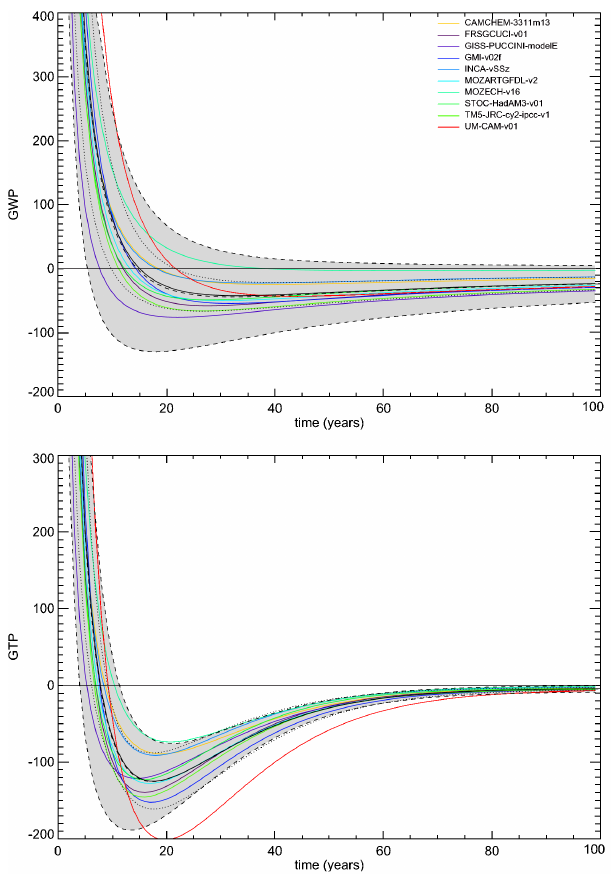
Figure 5. Time evolution of (top) GWP and (bottom) GTP for the NO x SA case, showing each model. The solid black line and sur- rounding dotted lines represent the model ensemble mean and stan- dard deviation. The dashed lines and shaded area represent the mean and standard deviation using the subsetting method of Fry et al.